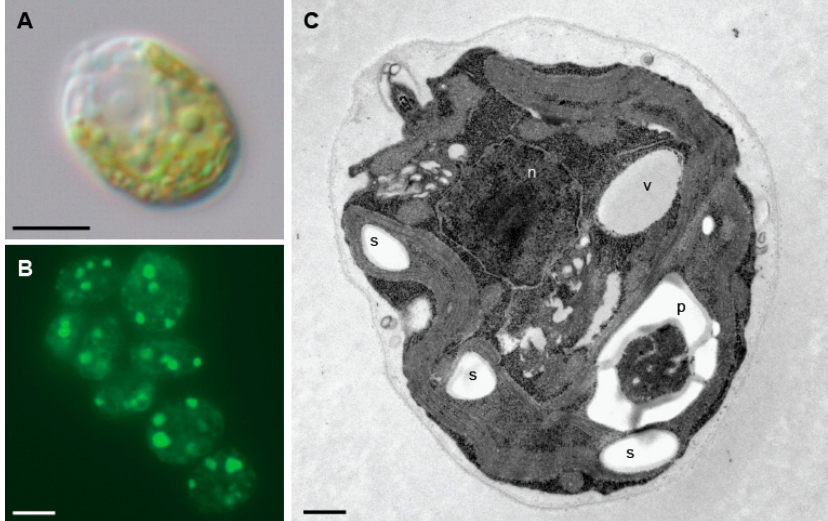
Figure 2. Microscopy images of Chlamydomonas cells. ( A ) Nomarski image of a Chlamydomonas cells. ( B ) Detection of lipid bodies by Nile red staining in Chlamydomonas cells under nitrogen limitation. ( C ) Ultrastructure of a Chlamydomonas cell. n, nucleus; p, pyrenoid; s, starch; v, vacuole. Scale bars: A and B, 5 µm; C, 500 nm.